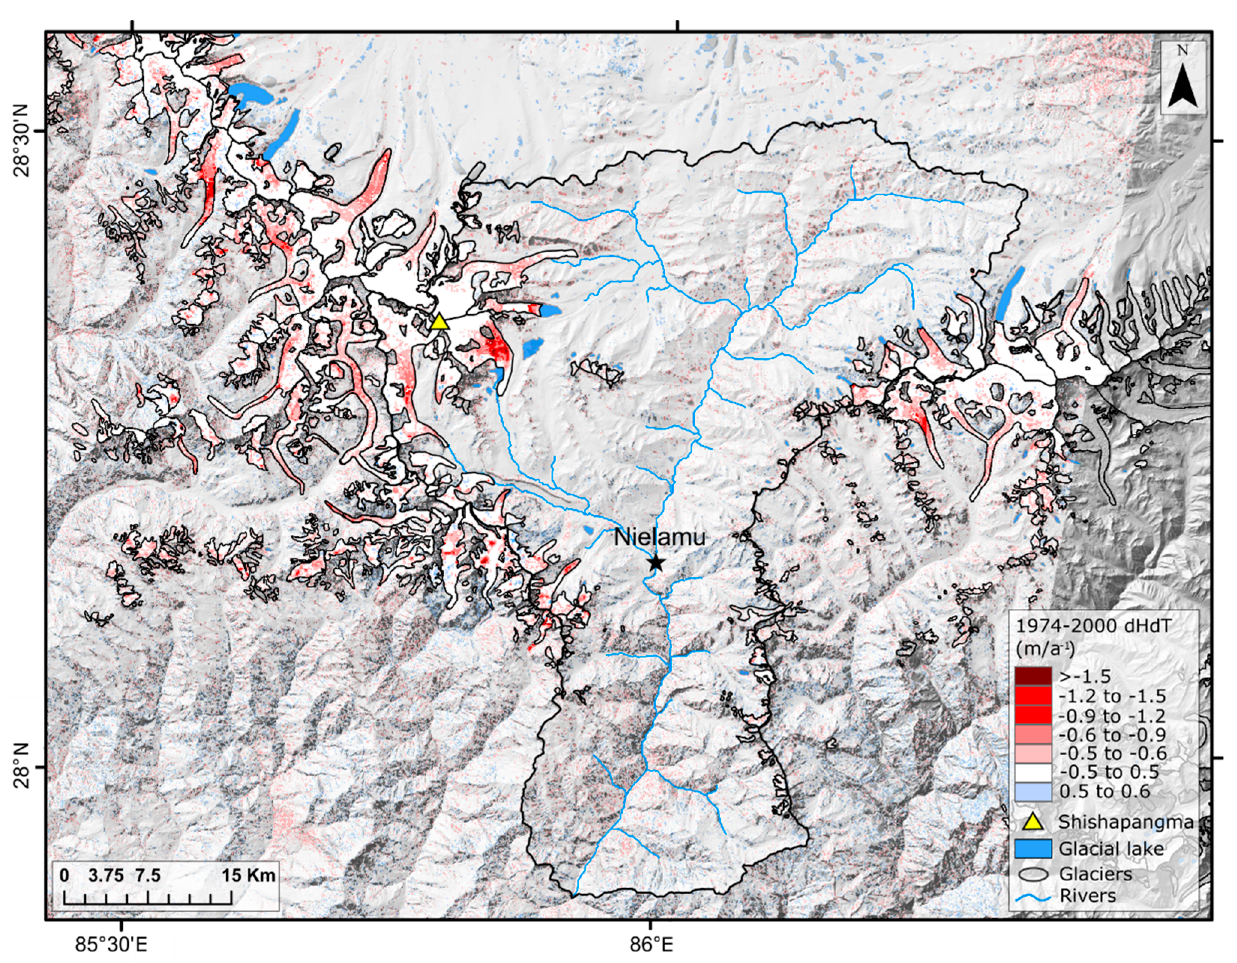
Figure 4. Glacier elevation changes in the Poiqu basin and surroundings (example): DEM difference between 1974 (KH9) and-2000 (SRTM Data) (data source: [6]).